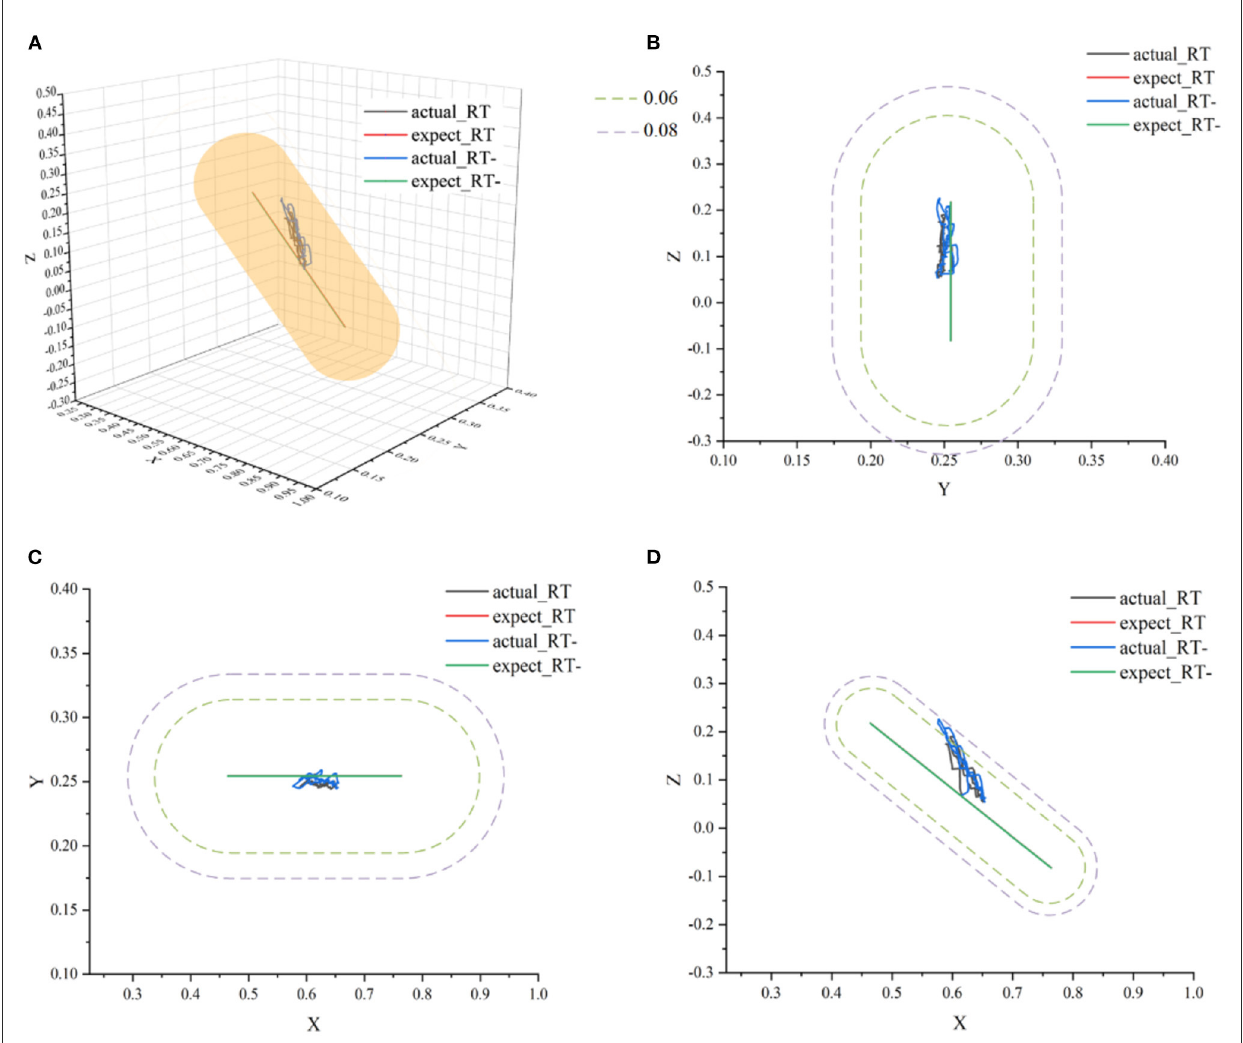
FIGURE14 The ideal movement trajectory and the actual training trajectory in the resistive training mode: (A) three-dimensional spatial view; (B) YOZ view; (C) XOY view; (D) XOZ